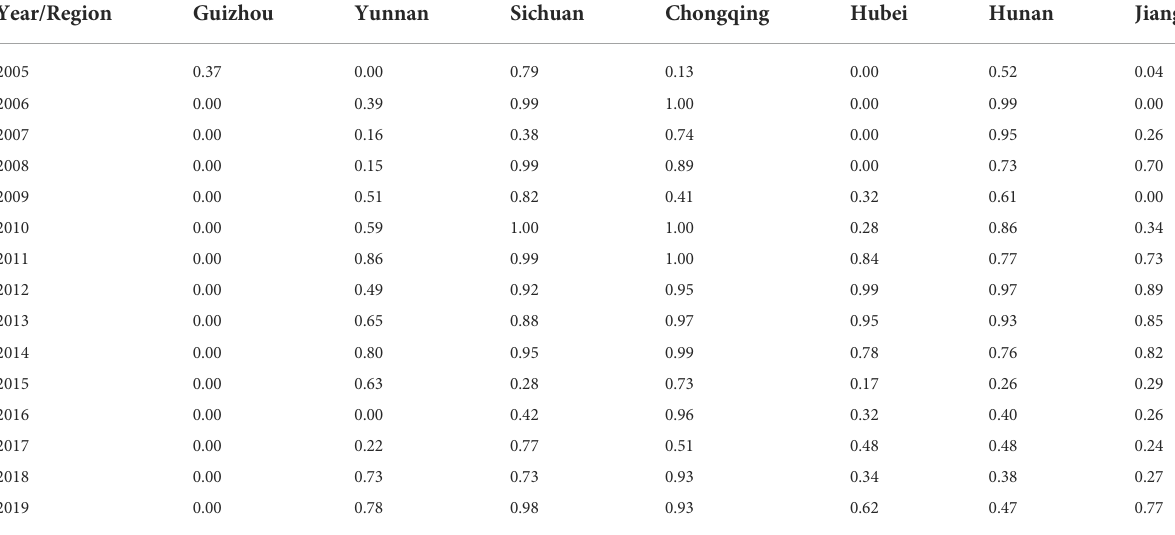
TABLE 6 The coupling of two-way FDI in central and western yangtze river economic belt.